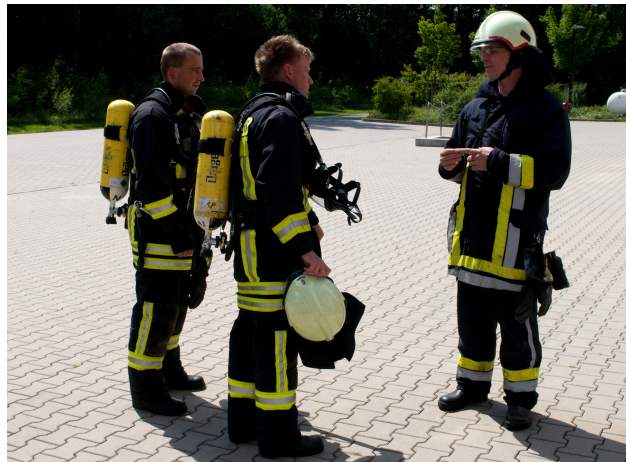
Figure 1. Before the start of a trial mission, the IC instructs the attacking team with exact details on how to approach the